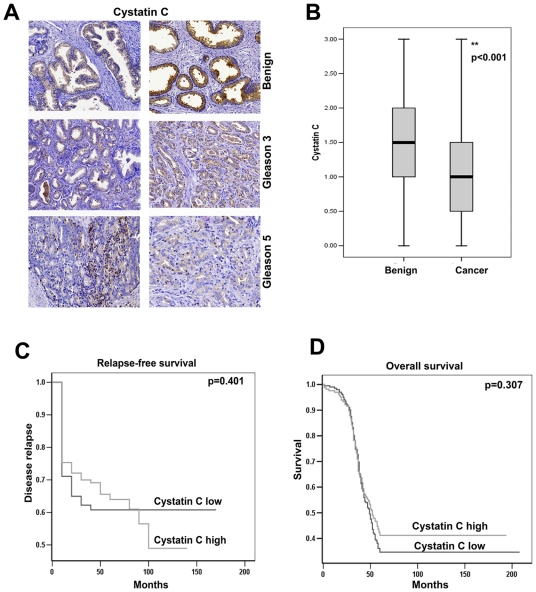
Immunohistochemical analysis of cystatin C expression in TMA with malignant and benign samples from patients with localized prostate cancer.
A). Immunohistochemical analysis of cystatin C expression in benign and PCa specimens. Sections representing benign, tissue and tumors of Gleason grade 3 and grade 5 are shown. Representative pictures were obtained using a 40x objective. B). The graph of quantitative analysis of immunohistochemical staining of Cystatin C (score 0-negative, 1- moderate, 2- strong, 3- very strong) shows the comparison between 448 benign and cancer specimens (average staining of duplicates of each specimen). The paired Wilcoxon's rank sum test analyses were used to assess the comparison between the groups. The mean values of intensities of staining (horizontal lines) with error bars representing 95% confidence intervals for the mean are shown. The boxes represent the distribution of the expression of cystatin C in the groups. C) Overall survival in patients with high or low expression of cystatin C in prostate cancer samples. Kaplan-Meier survival analysis was performed. D) Survival curves of time to relapse as evaluated as a biochemical recurrence measured as by raise of PSA [57] for the low (intensity score 0–1.5) and high (intensity score 2–3) cystatin C expression.